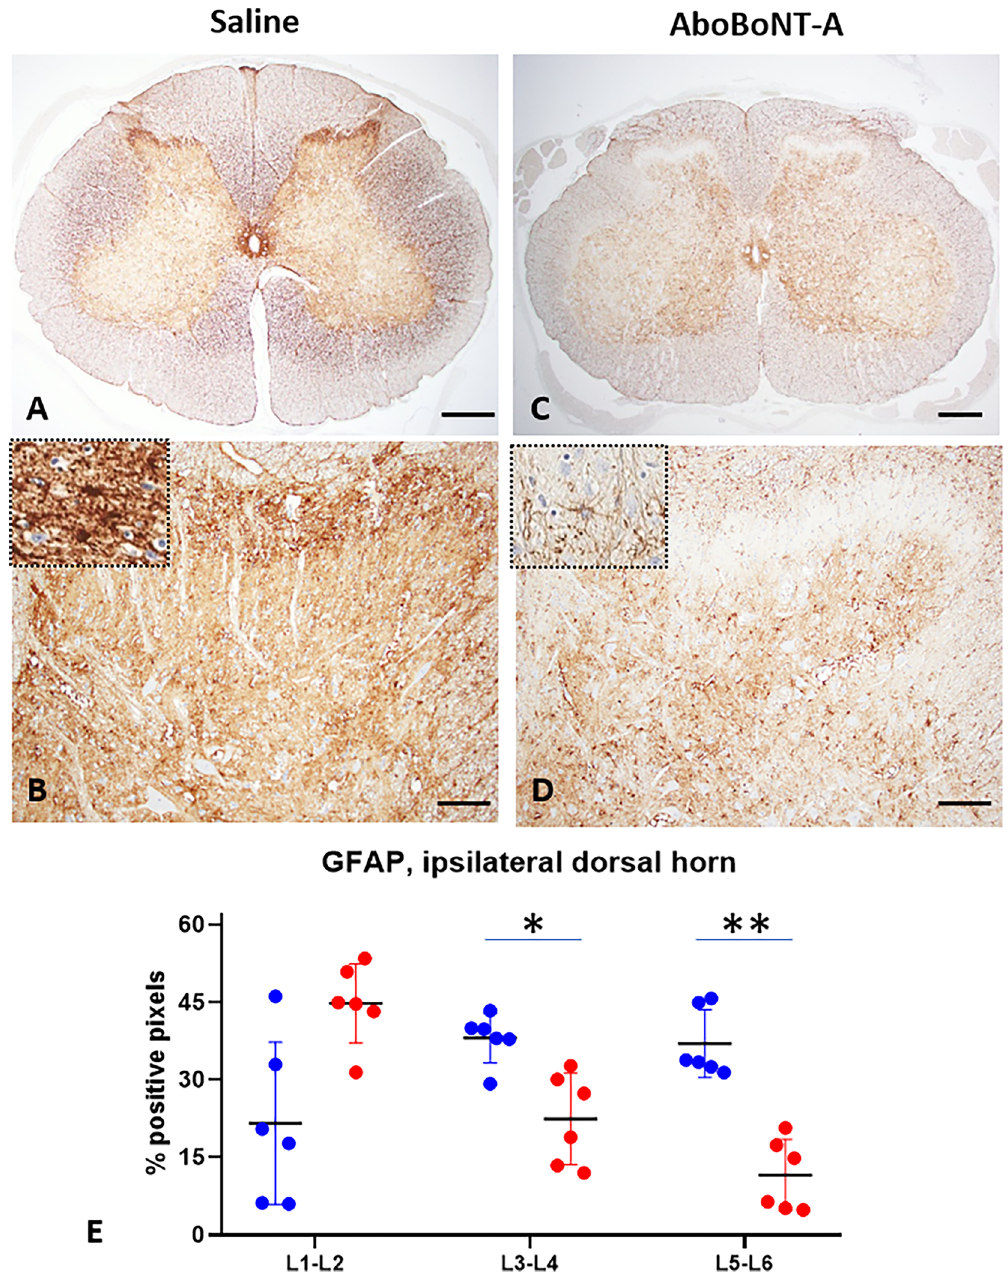
Figure 5. GFAP immunolabelling in the lumbar spinal cord of saline- and aboBoNT-A- treated animals. Photomicrographs are taken from L5-L6 sections of the lumbar spinal cord in representative animals that received a full-skin and muscle incision and retraction surgery (Day 0), followed by intraoperative treatment with either saline ( A, B ) or aboBoNT-A 400U ( C, D ) and tissue collection on Day 6. Scale bar: 1 mm ( A, C ), 200 µm ( B, D ). Insets in panels ( B ) and ( D ) depict GFAP stained astrocytes in saline- ( B ) and aboBoNT-A- treated ( D ) animals. Panel ( E ) shows quantification of GFAP immunolabelling in entire ipsilateral dorsal horns from lumbar (L) sections 1–2, 3–4, and 5–6 obtained from representative animals (n = 3/group) treated with either saline (blue symbols) or aboBoNT-A (red symbols; n = 2 sections per animal) as well as their mean values (± SEM). *p < 0.05, **p < 0.01 vs saline-injected animals. GFAP, glial fibrillary acidic protein; AboBoNT-A, abobotulinumtoxinA; U,